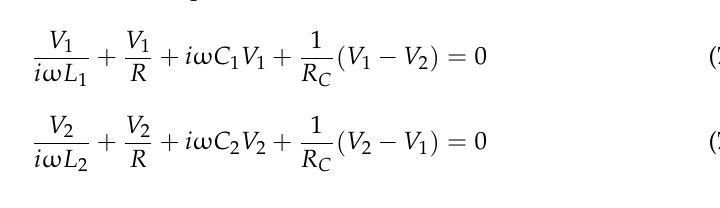
Figure 12 schematizes the idea of two coupled resonators for anti-PT symmetry pro- posed in